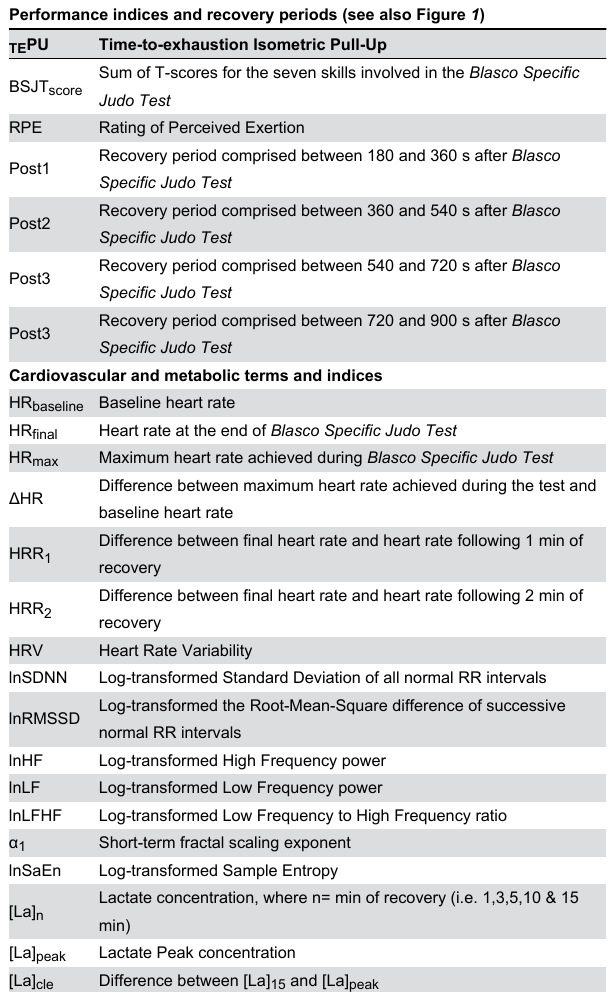
Table 1. Glossary of abbreviated terminology.